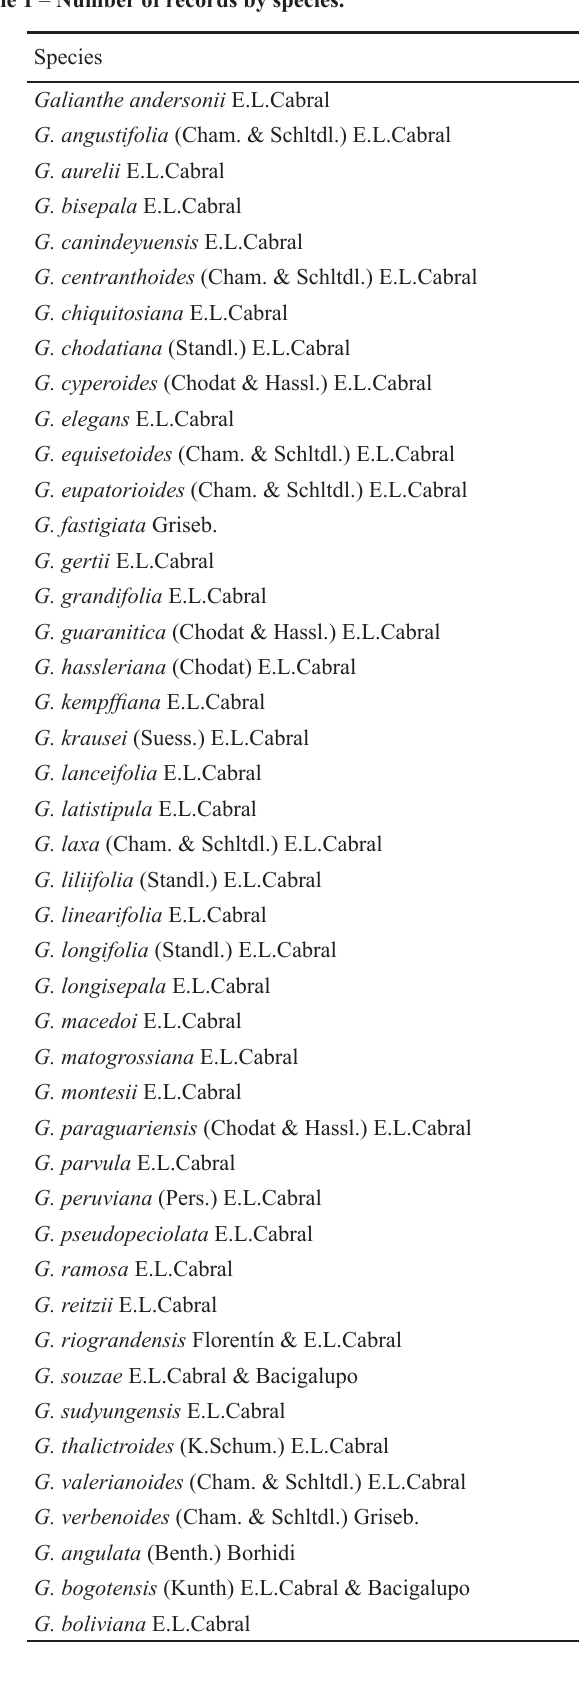
Table 1 – Number of records by